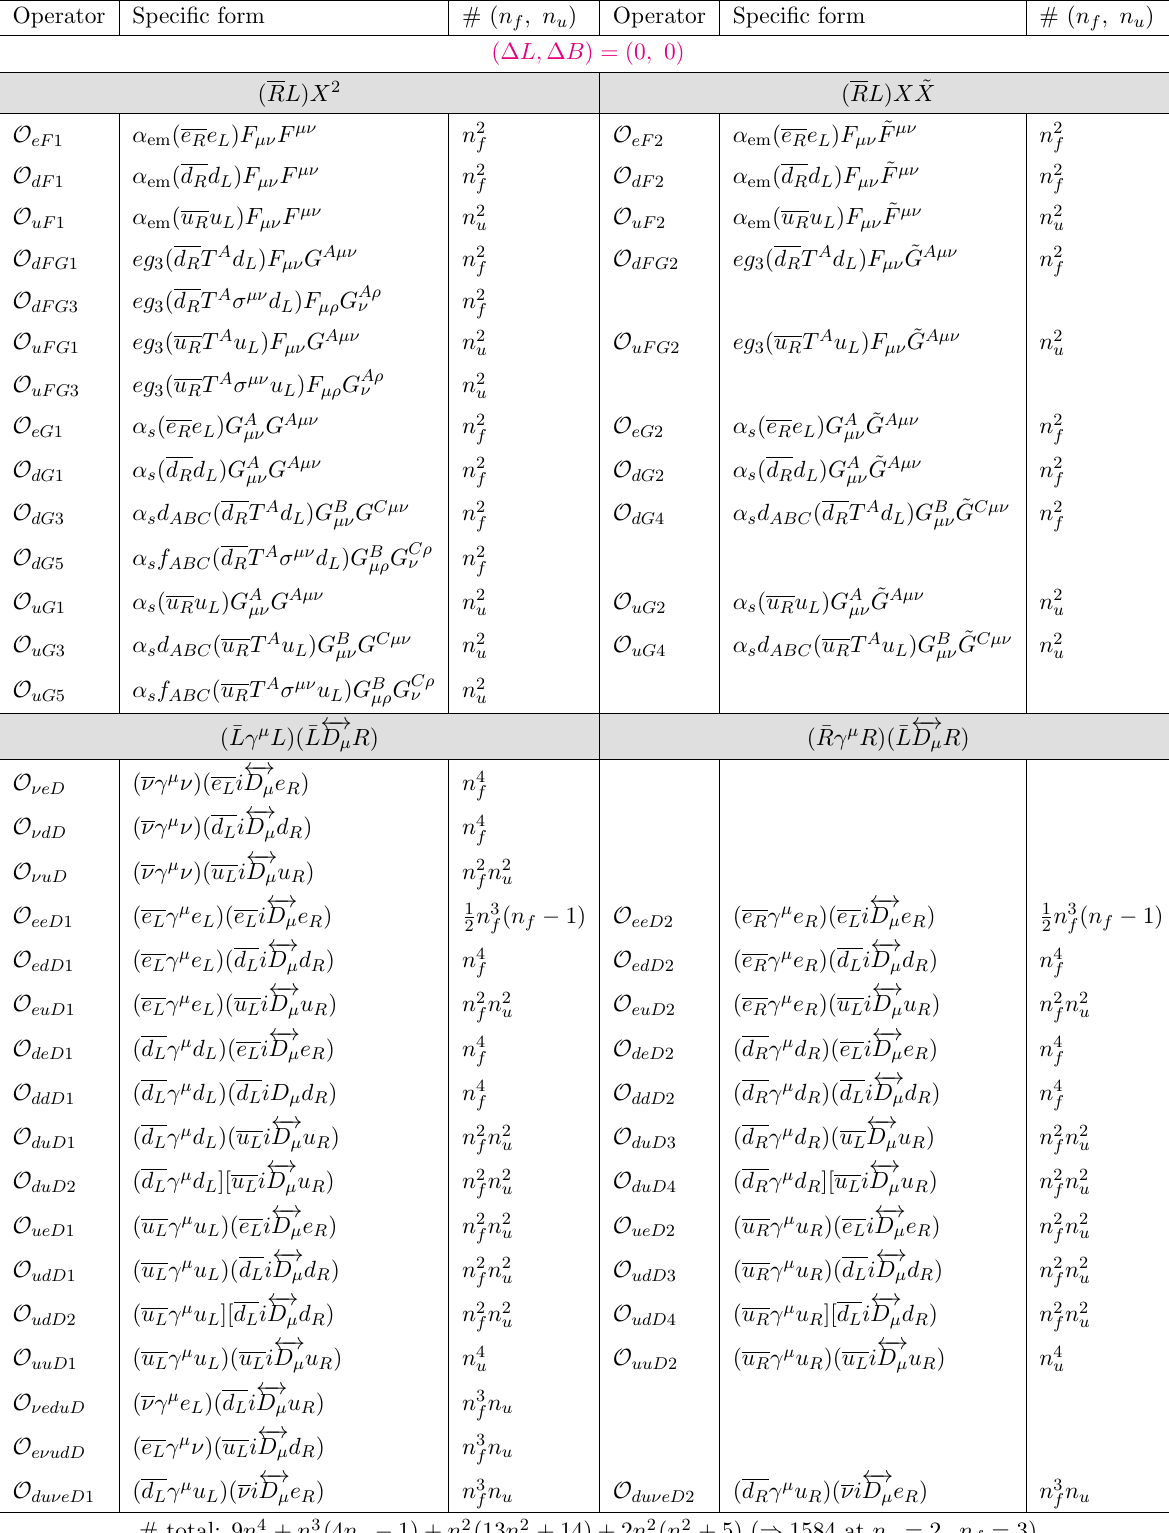
Table 1 . Basis of dim-7 operators in LEFT with lepton and baryon numbers conserved, i.e., (cid:1) B = (cid:1) L = 0, together with count of operators for general n u ; n f . L; R refer to left- and right- handed fermion (cid:12)elds, and (cid:11) em = e 2 = (4 (cid:25) ) and (cid:11) s = g 2 = (4 (cid:25) ). The two brackets ( ; ) and [ ; ] indicate s two di(cid:11)erent color contractions. Hermitian conjugate operators are not displayed.